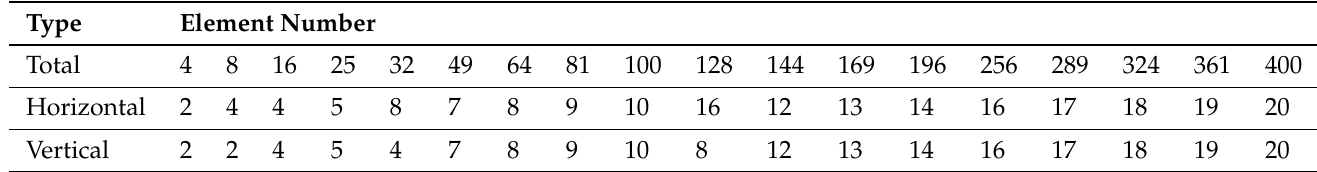
Table 3. The configuration of UPA elements in the horizontal and vertical dimensions.